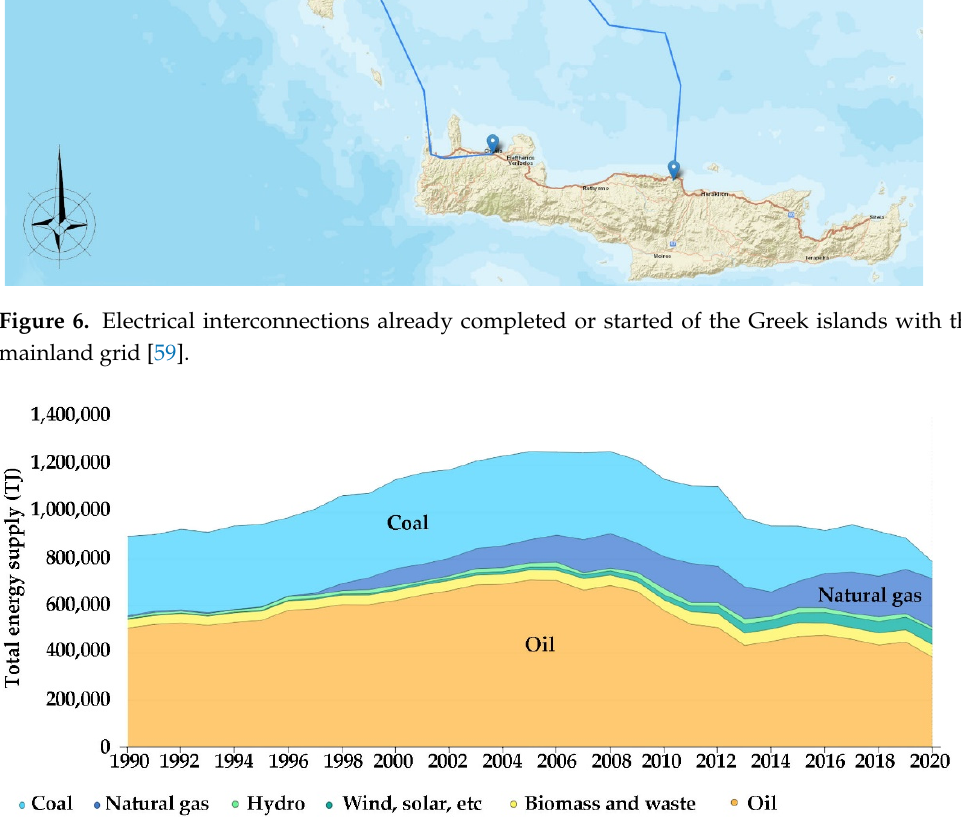
Figure 7. Evolution of total energy supply mixture in Greece from 1990 to 2020 [60].